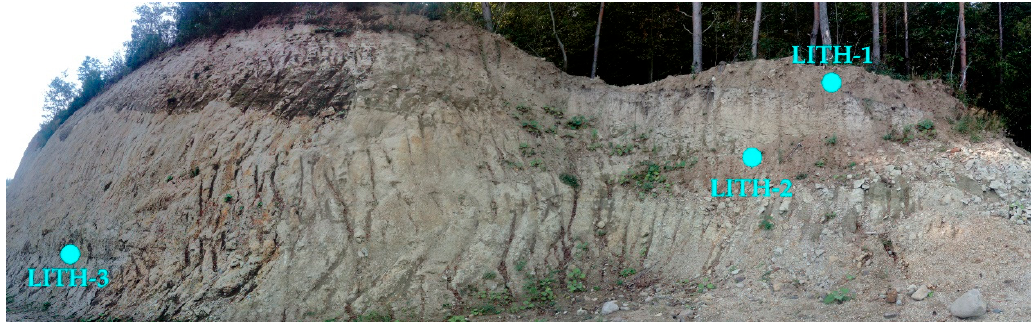
Figure 2. Profile 1—Location of point samples LITH-1–LITH-3.